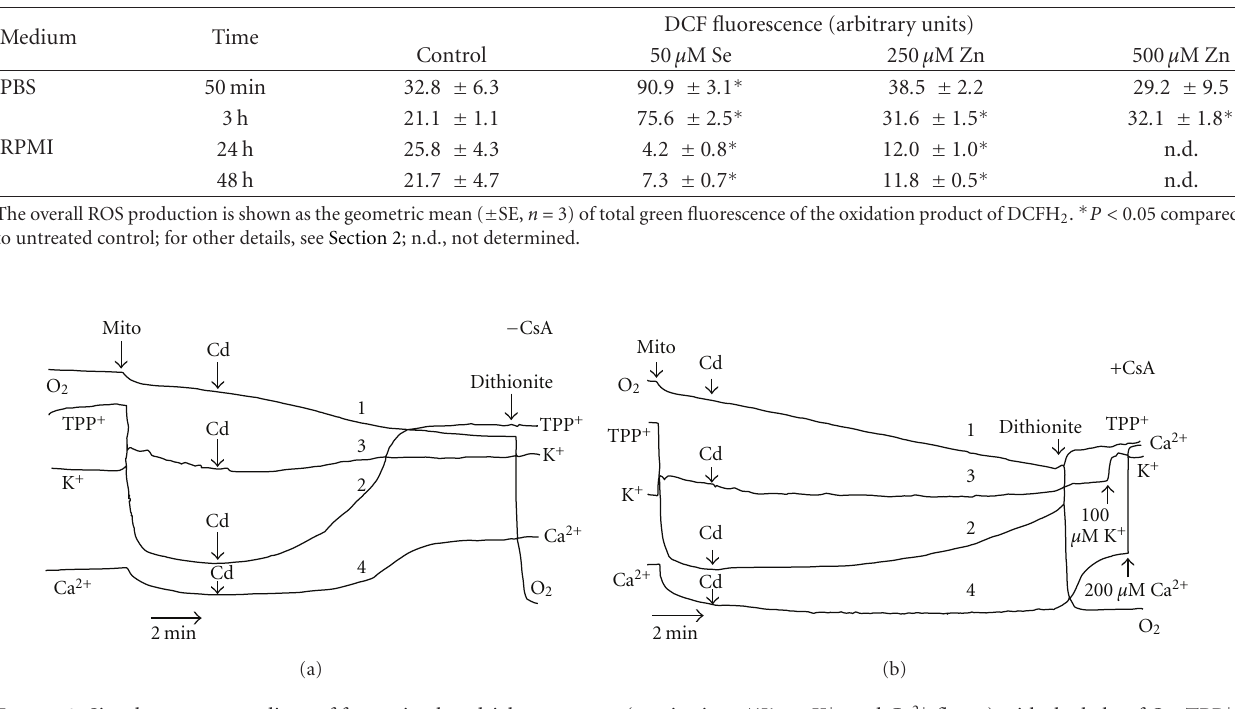
Table 4: Time-dependent e ff ects of high concentrations of Zn 2+ and selenite on ROS formation by AS-30D cells measured by flow cytometry using DCFH 2 -DA as ROS-sensitive probe.